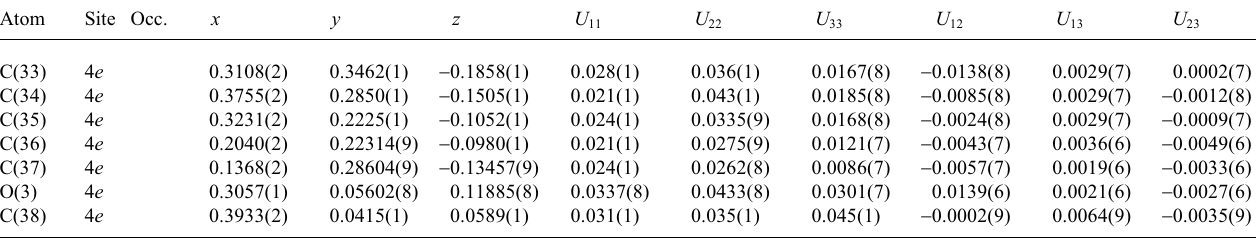
Table 3. Atomic coordinates and displacement parameters (in Å 2 ) . Atom Site